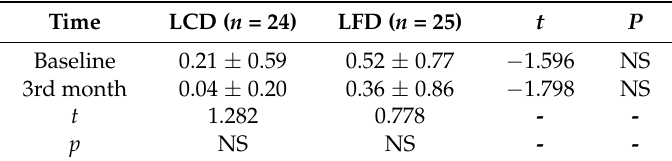
Table 9. Comparison of the frequencies of hypoglycemia between the two groups. Time LCD ( n = 24) LFD ( n = 25) t P Baseline 0.21 ± 0.59 0.52 ± 0.77 − 1.596 NS 3rd month 0.04 ± 0.20